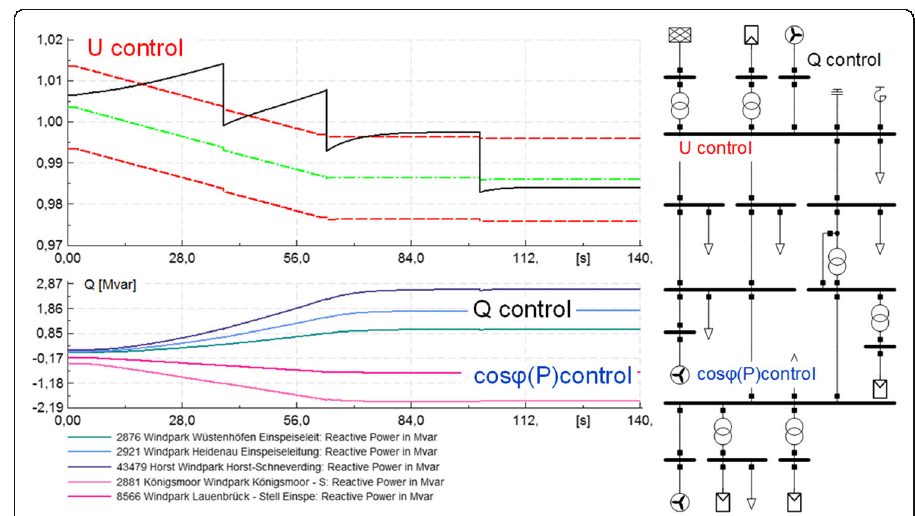
Fig. 1 Voltage variation considering the interaction of the on-load tap changer control and the cos φ